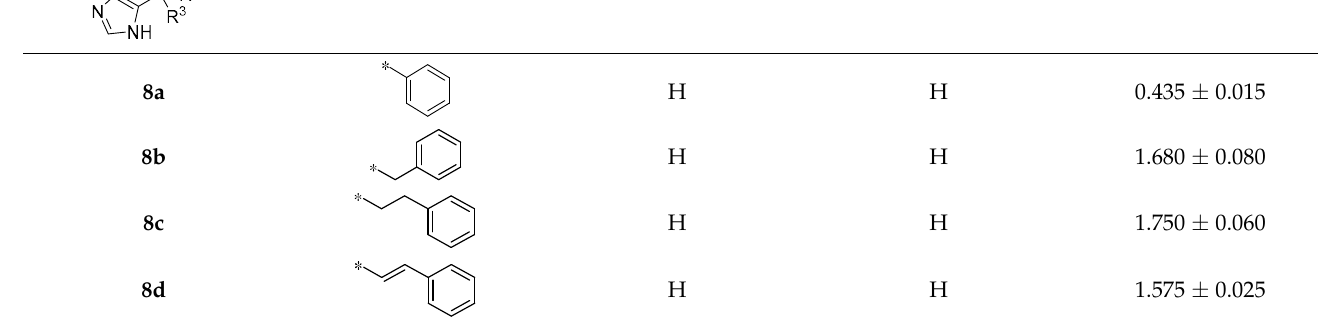
Table 1. Inhibition of PgQC by tetrahydroimidazo[4,5- c ]pyridines with alkyl and acyl modifications.